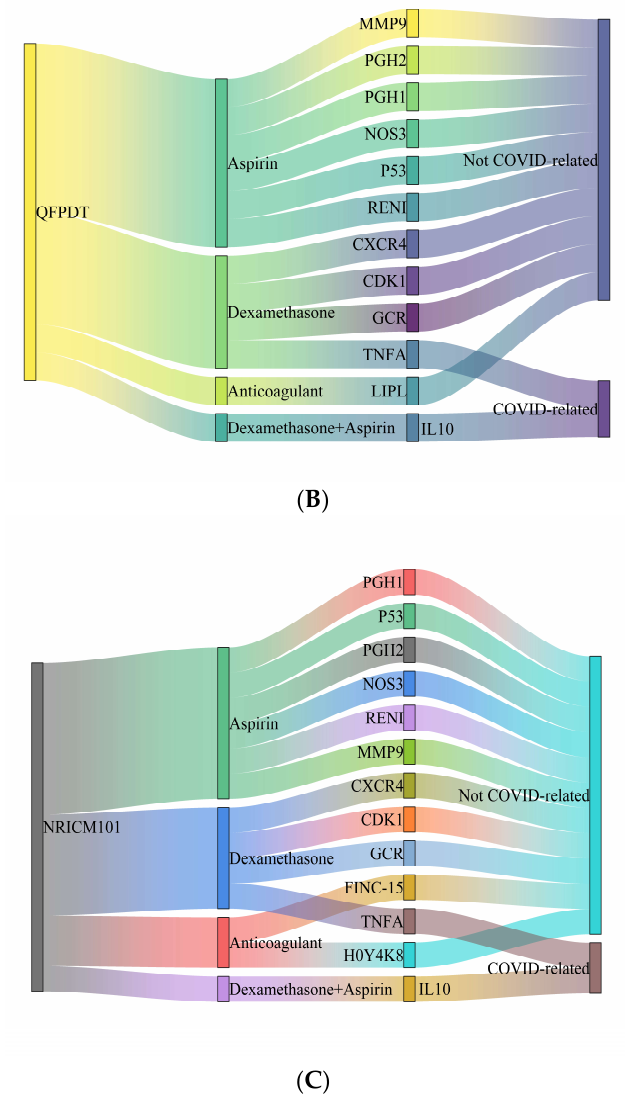
Figure 5. ( A )Target–drug interaction when HSBDF is used with WM in a Sankey diagram. ( B ) Target–drug interaction when QFPDT is used with WM in a Sankey diagram. ( C ) Target–drug interaction when NRICM101 is used with WM in a Sankey diagram.